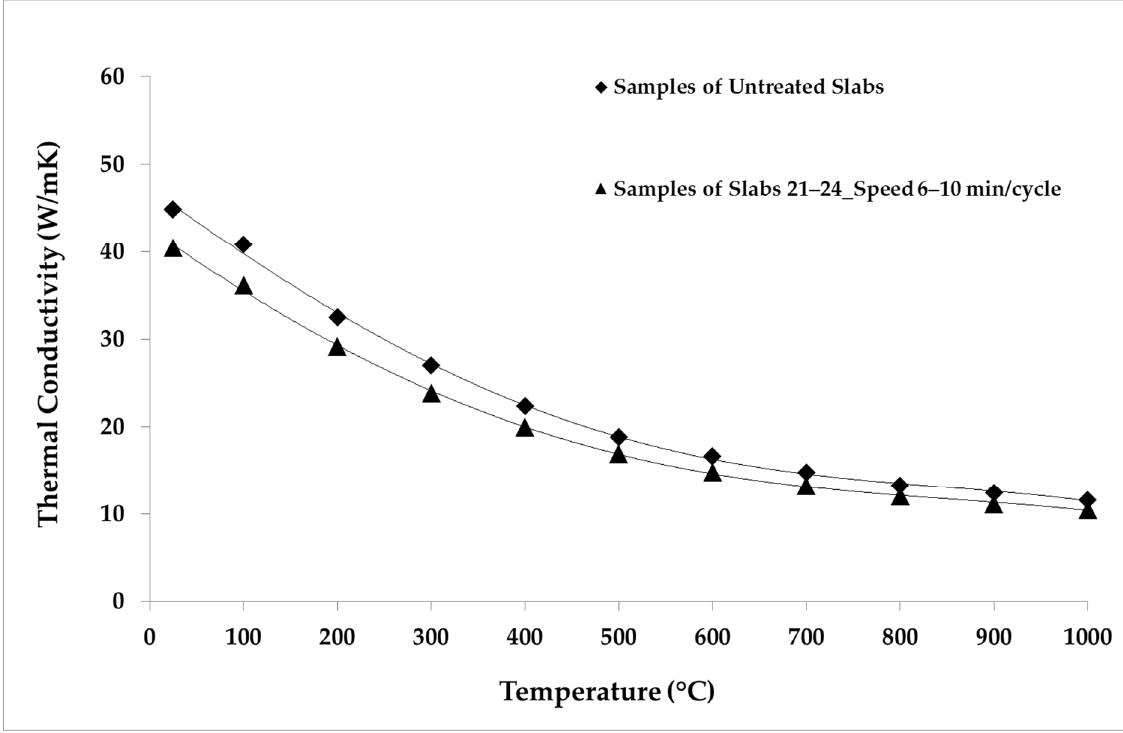
Figure 13. Thermal conductivity values of untreated samples and samples aged in the temperature range 300–1000 °C Table 4. Physical characteristics of the samples (all diameter 12.7 mm).